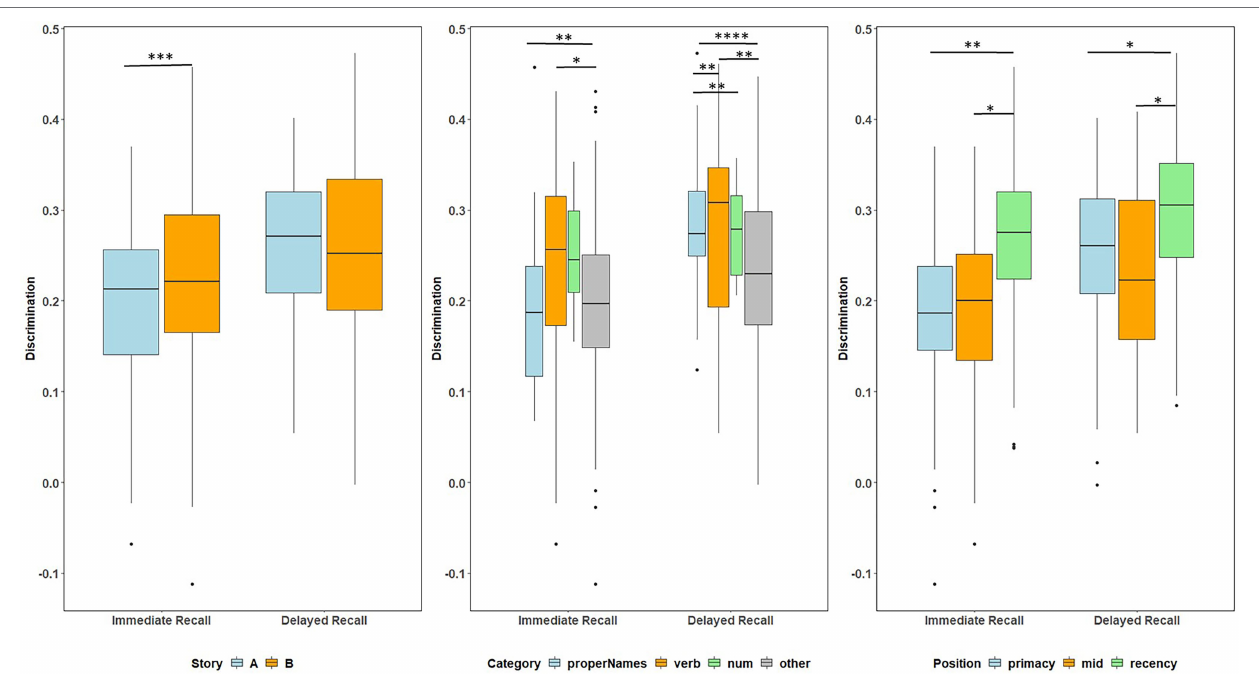
FIGURE 5 | Item discrimination plots at all visits according to the story (A and B), serial position (primacy, mid, and recency) as well as the lexical category (proper names, verbs, numbers, and others) of the items, by immediate recall and delayed recall. The corresponding model information is in Table 3 . Post hoc pairwise group differences at unadjusted p < 0.05 noted as *< 0.05, **< 0.01, ***<0.001, and ****<0.0001.